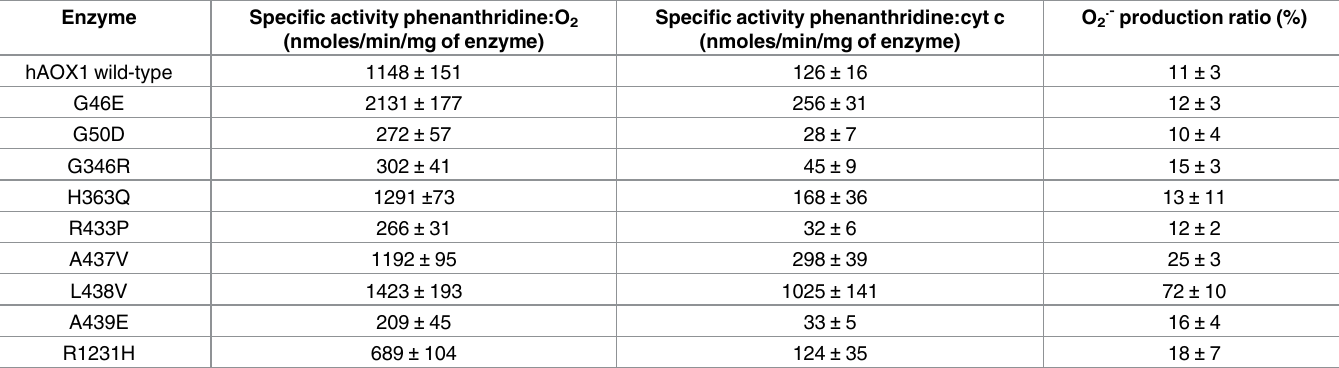
Table 2. Superoxide production of hAOX1 wild-type and